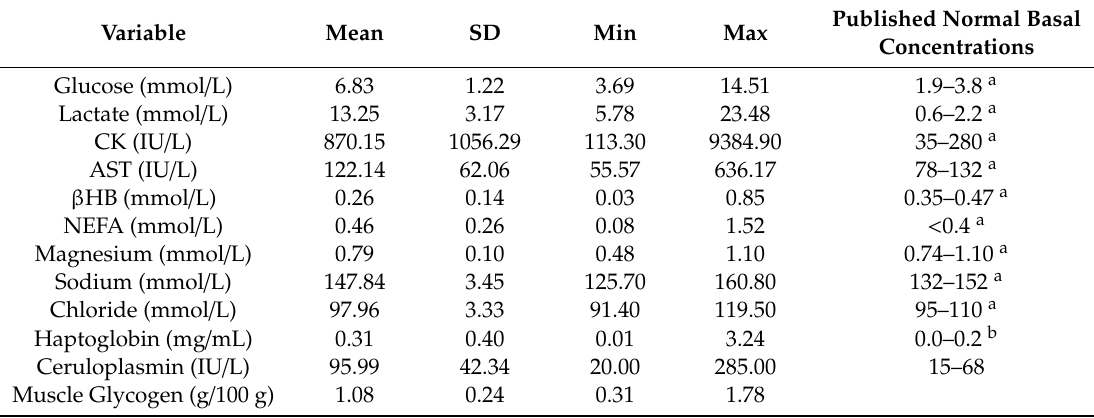
Table 1. Descriptive statistics of plasma metabolites taken immediately at slaughter and m. longissimus lumborum glycogen.